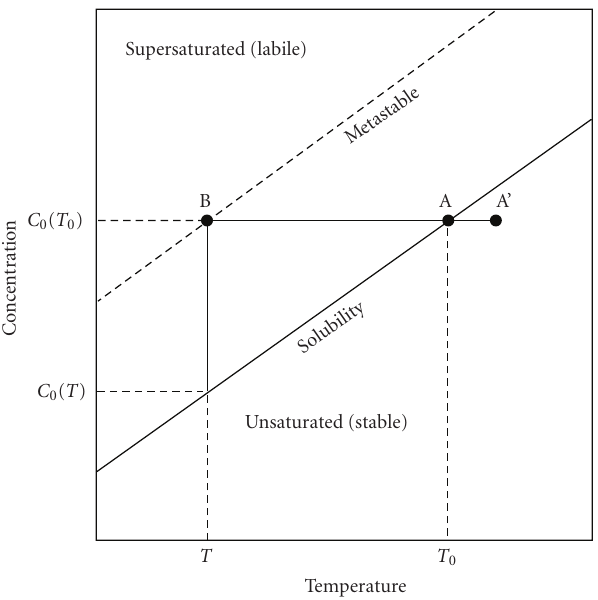
Figure 1: Phase diagram for a binary system of